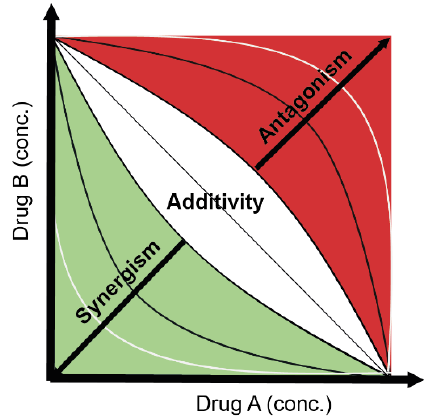
Figure 1. Schematic isobologram showing the equi-effective Cartesian plane for the combination of Drug A and Drug B at a specific effect level fa (for example fa = 0.5). For any mixture ratio (A:B), the effect of A + B should be theoretically located on the straight transversal line (the additivity line). The additivity effect can consider uncertainty (depicted by the white region). When the doses of A + B required to get the desired effect ( fa ) is less than that expected from their theoretical fractional summation of their respective individual effects (see Equation (4)), the effect of A + B is synergistic, and their coordinate location in the isobologram Cartesian plane is below the additivity line, depicting synergism. The opposite case indicates antagonism. Figure adapted from Cokol et al. [25]. Copyright 2011, EMBO and Macmillan Publishers